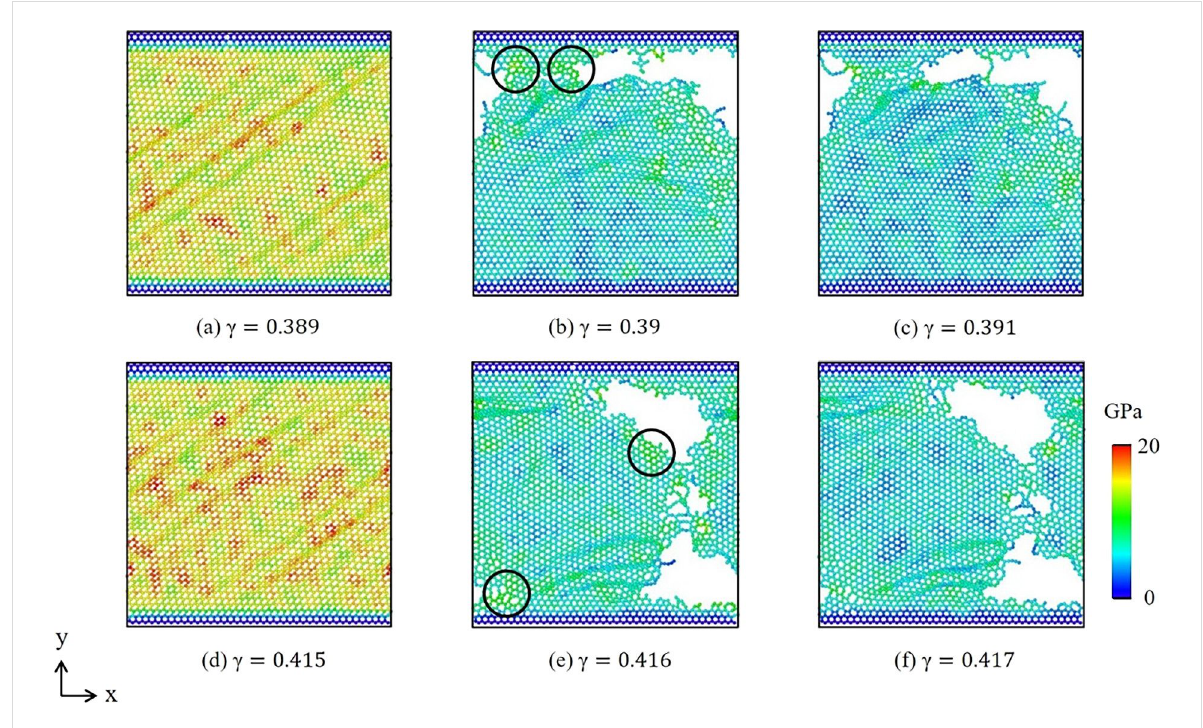
Figure 6: (a–f) Von Mises stress of graphene under shear loading along the zigzag direction at 300 K. (a–c) Top graphene sheet, (d–f) bottom graphene sheet.